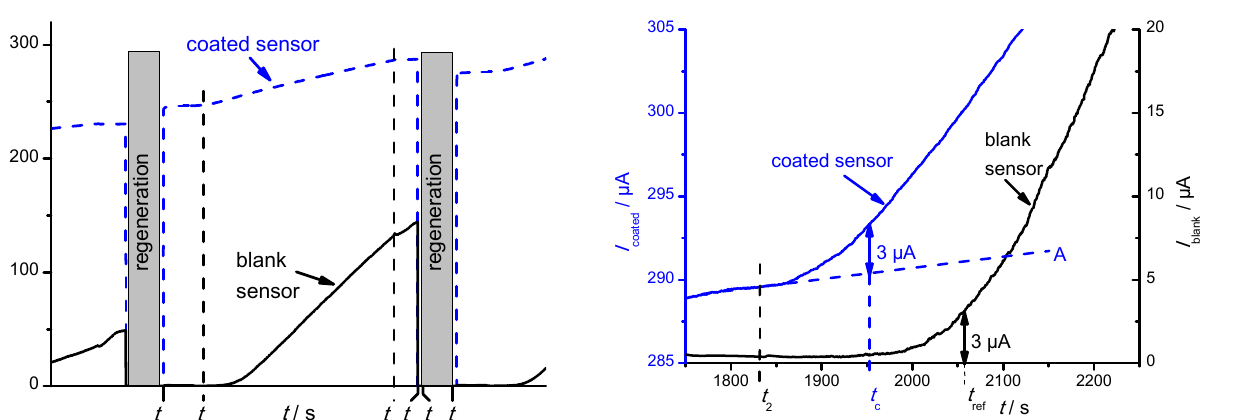
Figure 9. Typical measurement and regeneration cycle. t 1 : sensor voltage over the IDE is applied, t 2 : artificial soot source is switched on, t 3 : artificial soot source is switched off, t 4 : sensor voltage is switched off, t 5 to t 6 : heater current for regeneration is applied.